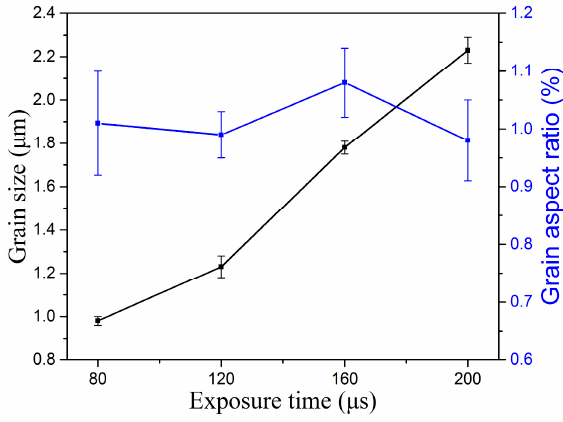
Figure 11. Grain size and aspect ratio of different exposure times.